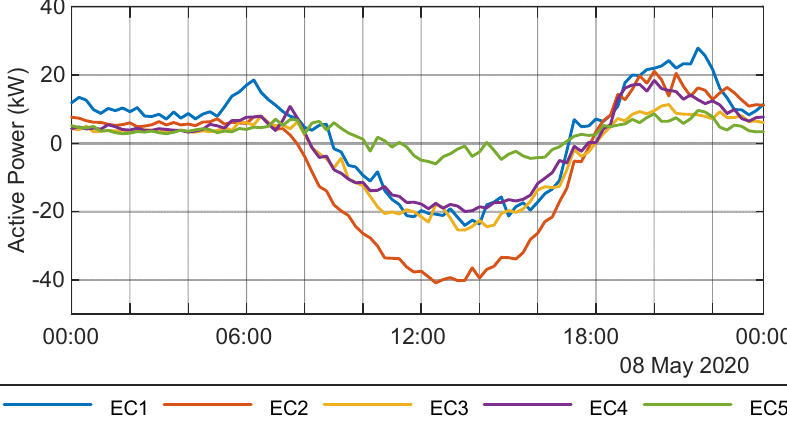
Figure 12. The hourly net demand curves for all ECs on 8 May 2020.